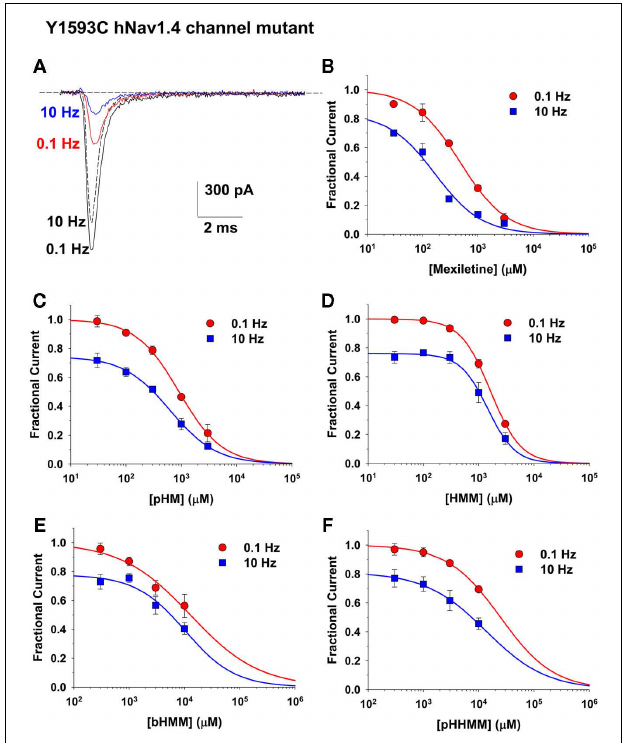
FIGURE 6 | Concentration–response relationships for mexiletine and hydroxylated analogs onY1593C hNav1.4 channel mutants. (A) Representative sodium current traces recorded in a HEK293 cell permanently transfected withY1593C hNav1.4 mutant, by depolarizing the cell to − 30mV from an holding potential of − 120mV at 0.1 and 10Hz stimulation frequency, before and during application of 1mM mexiletine. Note the use-dependent current reduction in absence of drug. ( B–F) The concentration–response relationships were constructed at 0.1 and 10Hz frequency stimulation, and fitted with a first-order binding function (Eq. 1 in Materials and Methods). Each point is the mean ± SEM from at least three cells.The calculated IC 50 and I max values ± SE of the fit are reported in Table 2 .The slope factors ranged between 0.69 and 1.76.